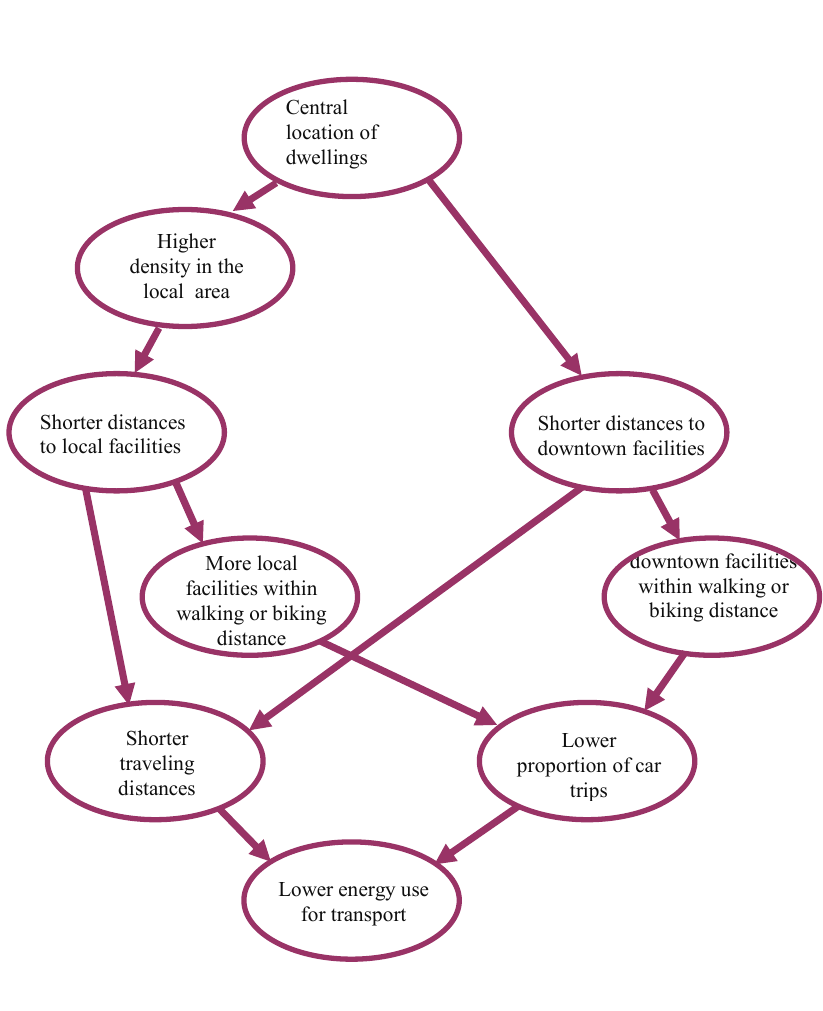
Figure 5. Schematical illustration of how the location of residences relative to the centre